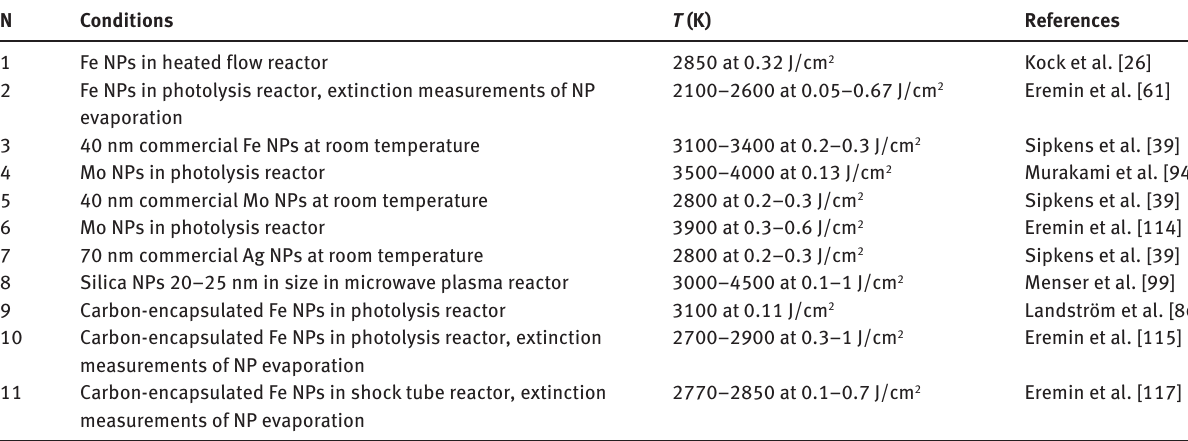
Table 4: The non-soot particle peak temperatures measured by pulsed laser heating. N